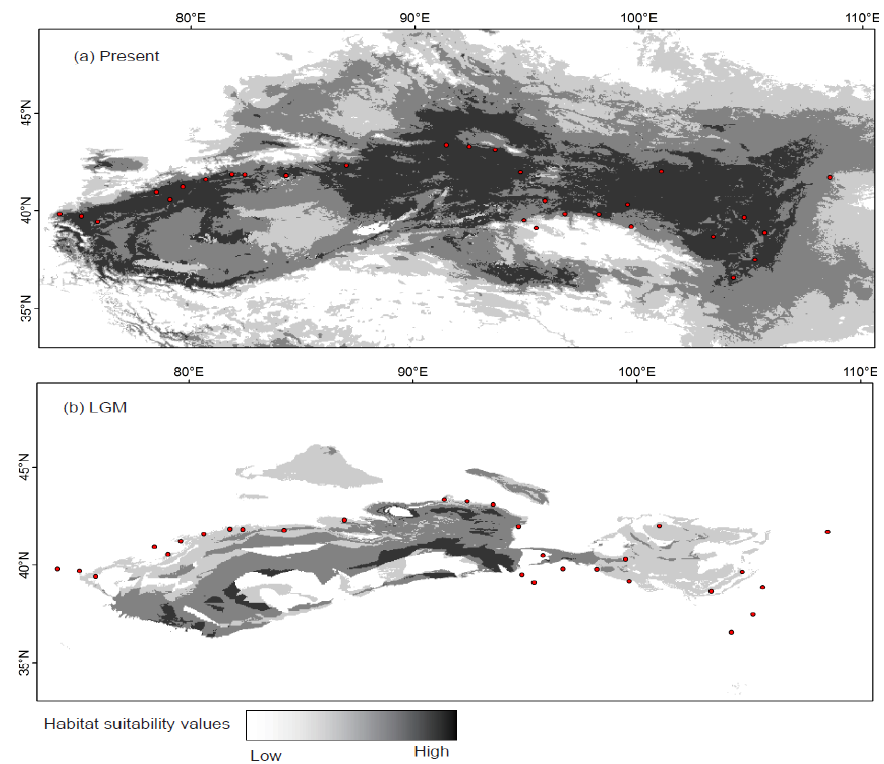
Figure 5. Potential distributions with occurrence probability of Gymnocarpos przewalskii during ( a ) present-day and ( b ) last glacial maximum (LGM) based on the Model for Interdisciplinary Research on Climate- Earth System Model (MIROC-ESM) model. The dots show the occurrence points used in the species distribution modelling (SDMs). Table 2. Values from best model for general linear model analysis between the genetic diversity of Gymnocarpos przewalskii with geography, environment and habitat factors based on the backward eliminating procedure. Allelic Richness (A r )